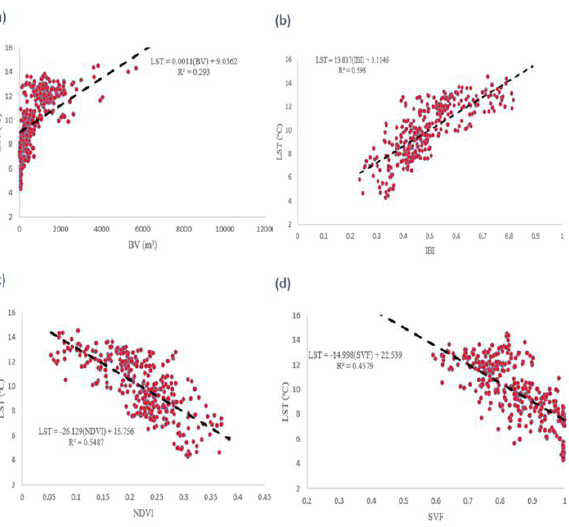
Figure 5. Correlation between LST and (a) BV; (b) IBI; (c) NDVI and (d) SVF